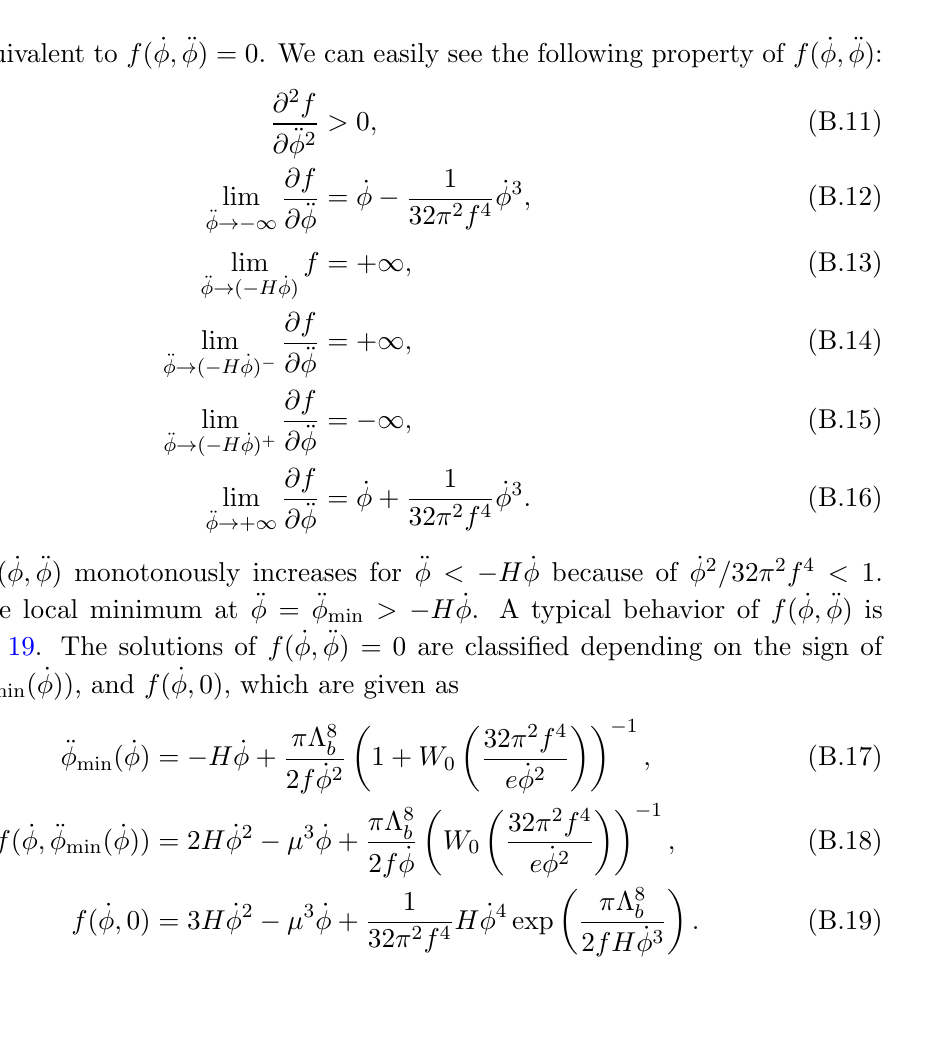
Figure 19 . A typical behavior of f ( _ (cid:30); (cid:127) (cid:30) ) as a function of (cid:127) (cid:30)